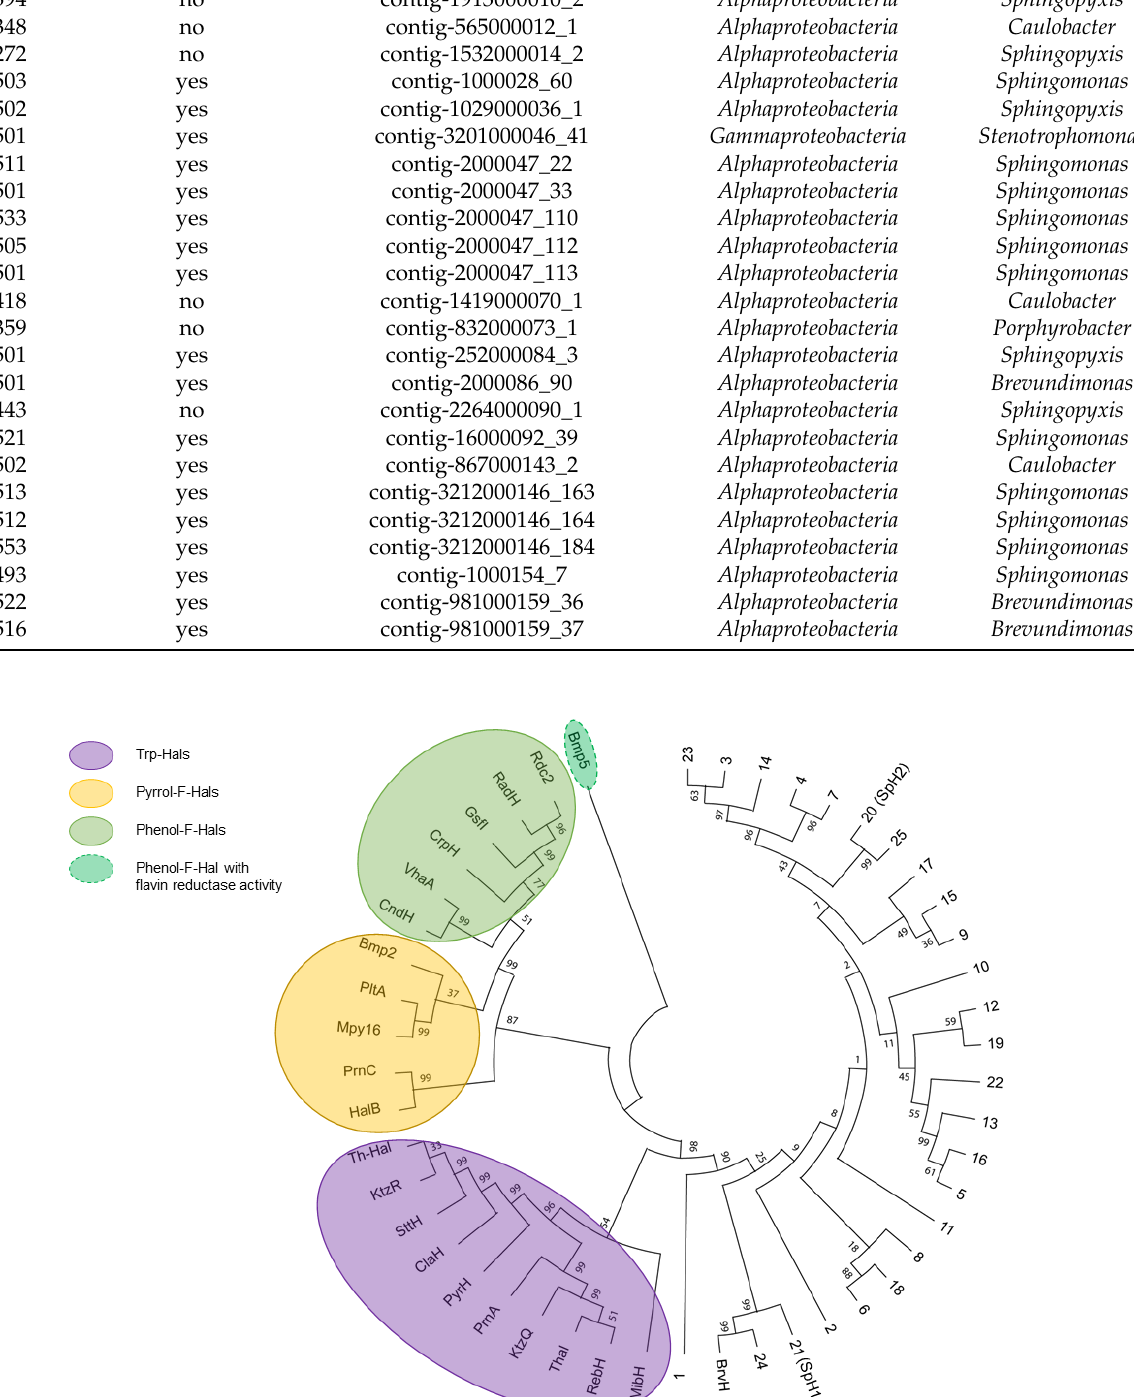
Figure 2. Gene cluster in the vicinity of hit 21 (J; SpH1) in the metagenome-assembled genome (MAG) 21 of the B. braunii bacterial consortia. Another flavin-dependent halogenase gene, sph2 (J), was identified upstream to sph1 (I). The genes I, J, K, and L were found to be encoded on the same contig in the metagenomics dataset. Since many flavin-dependent halogenases originating from the same gene cluster were reported to act in concert [17,19,46], both putative, flavin-dependent halogenases 21